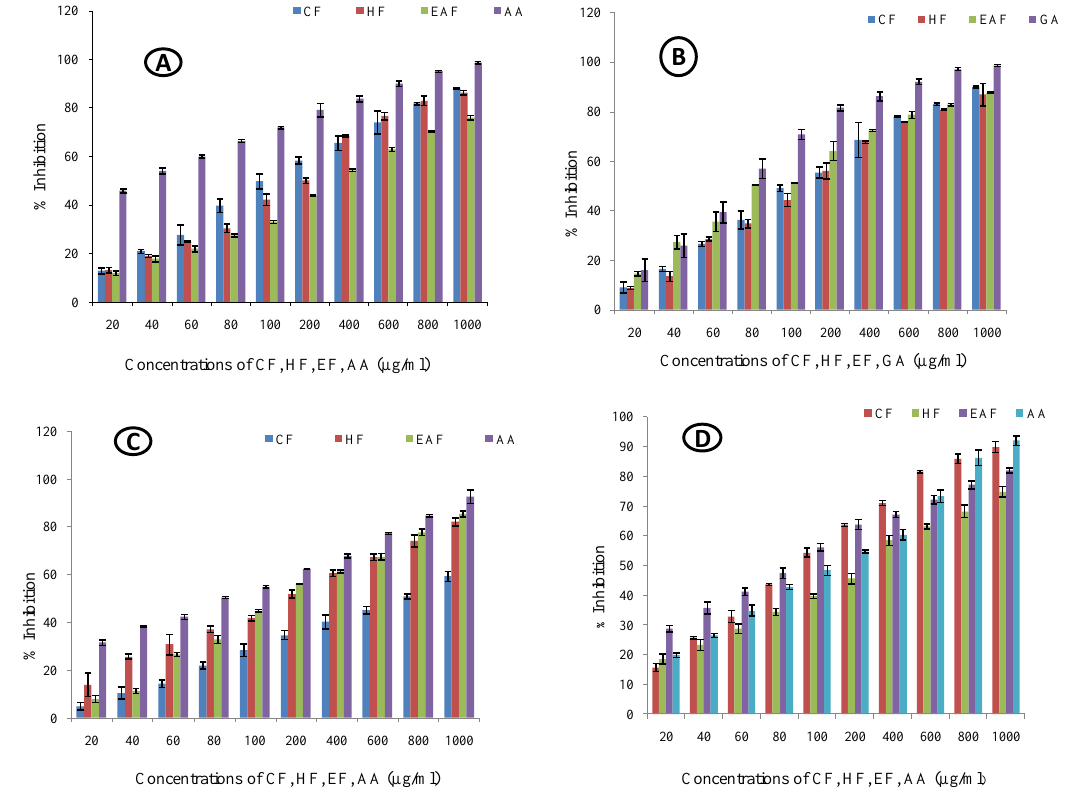
Figure 1. Antioxidant activity of Rhododendron arboreum fractions: ( A ) Nitric oxide scavenging assay; ( B ) Lipid peroxidation assay; ( C ) Site specific deoxyribose deprivation assay and; ( D ) Non- site specific deoxyribose deprivation assay. (CF- chloroform fraction; HF- hexane fraction; EAF- ethyl acetate fraction; AA- ascorbic acid; GA- gallic acid).